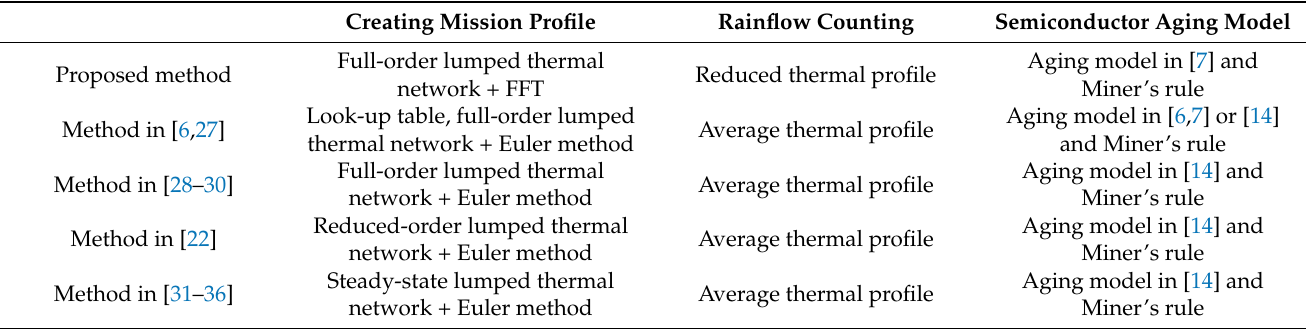
Table 13. Comparison of the proposed aging simulation and aging simulations available in the literature.